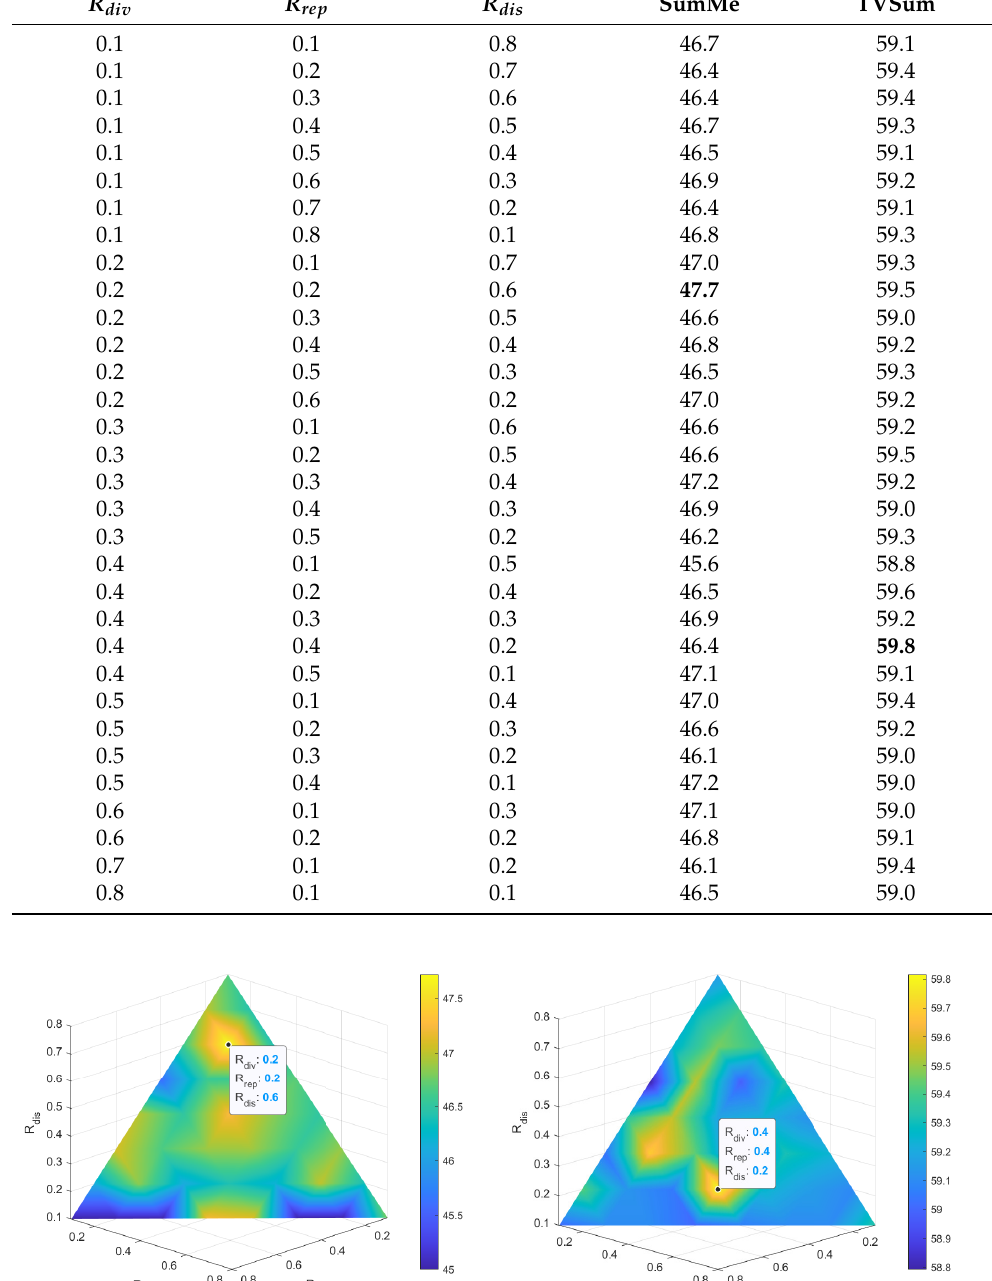
Table 9. Effects of different reward weights on SumMe and TVSum performance (F-scores).